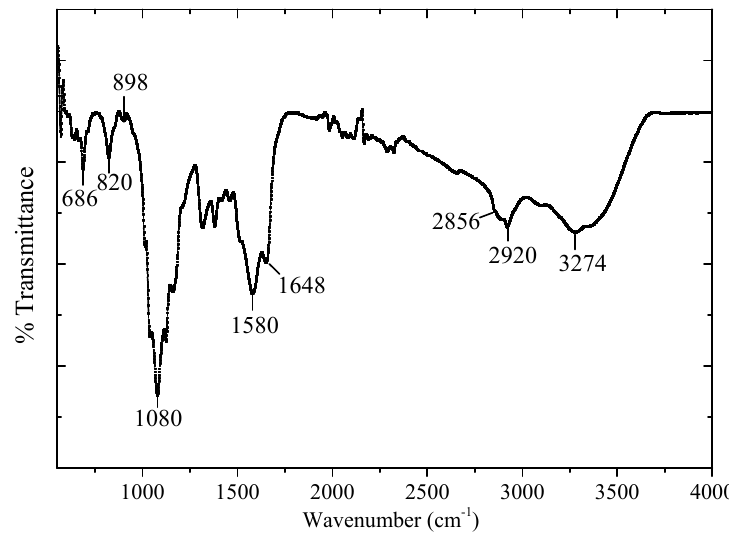
Figure 2. FTIR spectra of chitosan-Polyethylene glycol blend.